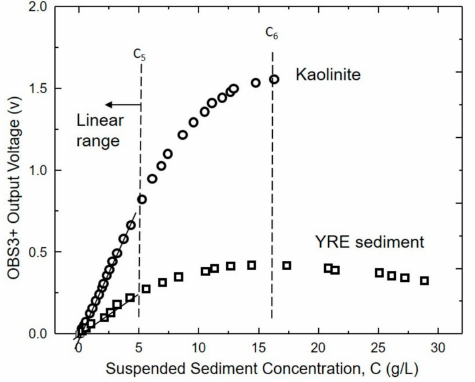
Figure 5. OBS3+ responses to the changes of SSC for YRE sediment and kaolinite.